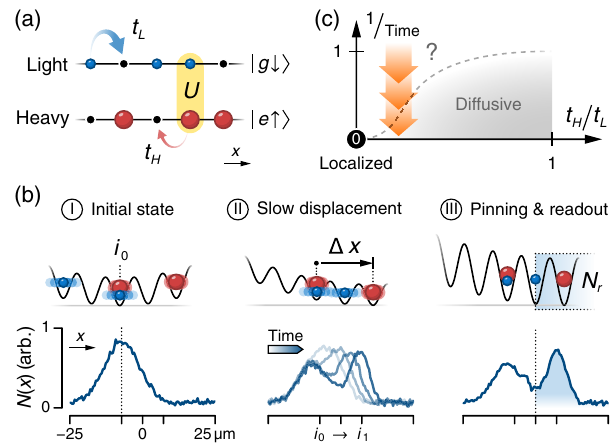
FIG. 1. Transport in the mass-imbalanced Fermi-Hubbard model. (a) Illustration of the mass-imbalanced Fermi-Hubbard ≫ t model with on-site interaction U and hopping t of the light L H (blue circles) and heavy (red circles) particles, respectively. We also show the atomic states relevant for the experimental imple- mentation. (b) Schematic representation of the different steps in our transport measurement (top row) and integrated densities of the light atoms (bottom row) from experimental snapshots. (c) Scenario for the transient regime following a quench in the mass-imbalanced Fermi-Hubbard model for a variable inverse hold time (vertical axis). Here, the dashed line marks the crossover between uncon- ventional relaxation dynamics at early times (question mark) and diffusion at late times. The orange arrows indicate a trajectory in the regime of our